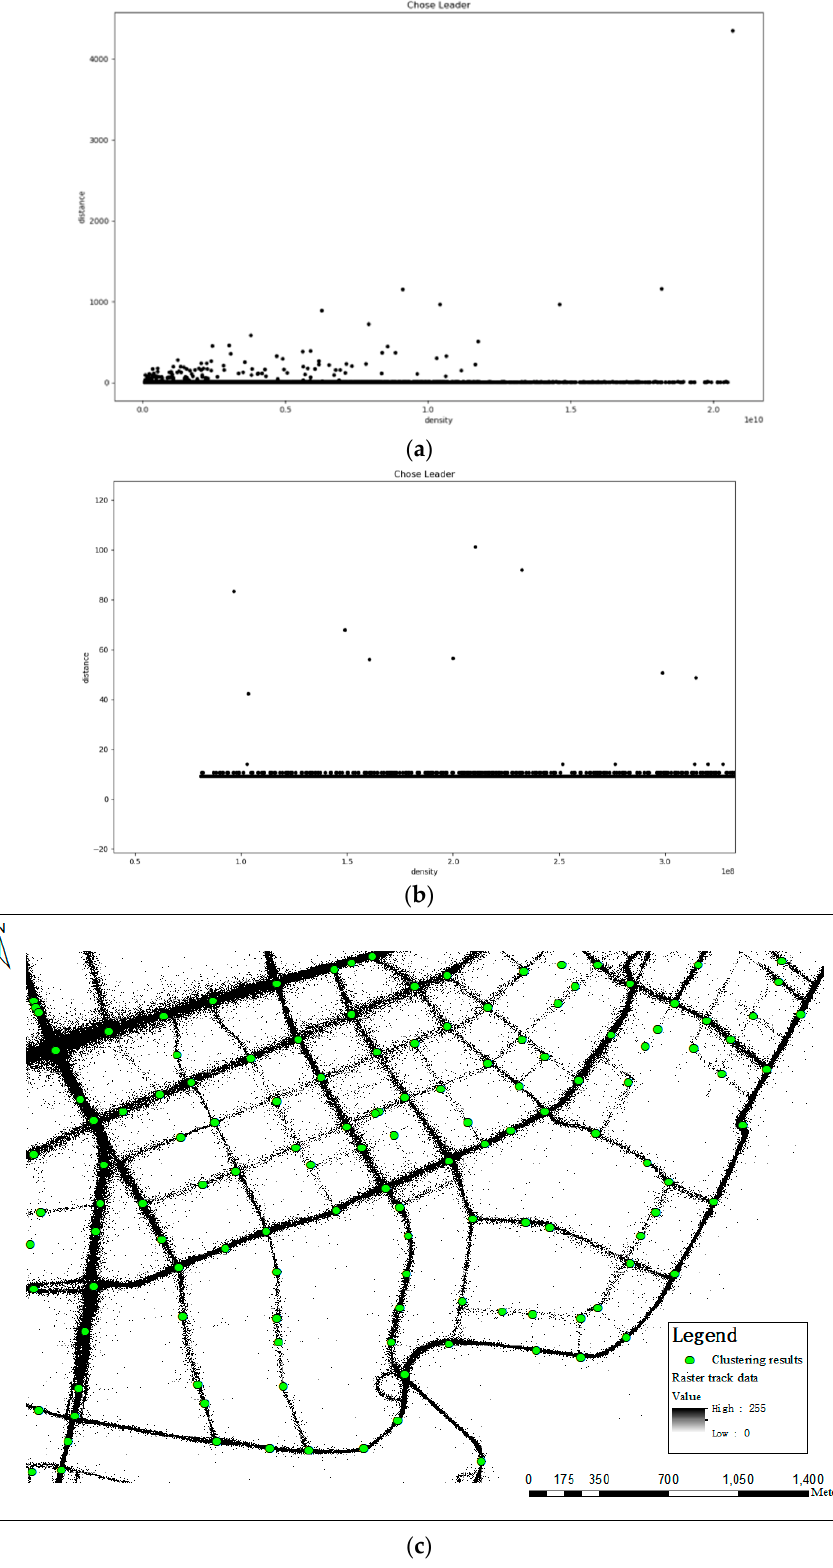
Figure 8. Extraction results by clustering: ( a ) decision graph; ( b ) amplifying result; ( c ) intersection extraction results (overlaying 2.5 m raster track data).